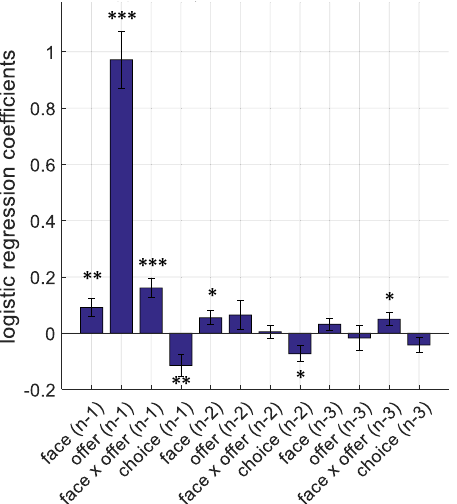
Fig. 4 Logistic regression analysis of participant choice behaviour. Coef fi cient estimates from the logistic regression model fi tted to participant choices on the current ( n th) trial indicate that all regressors from the n -1th trial signi fi cantly in fl uence participant choice behaviour (*** p < 0.001, ** p < 0.01). The coef fi cient estimates for the in fl uence of previous choices were all negative, indicating that offers on the current trial are more likely to be accepted if offers on previous trials were rejected. The in fl uence of these variables decayed down the trials. Error bars denote ±1 SEM. The average variance in fl ation factor computed for these 12 regressors was